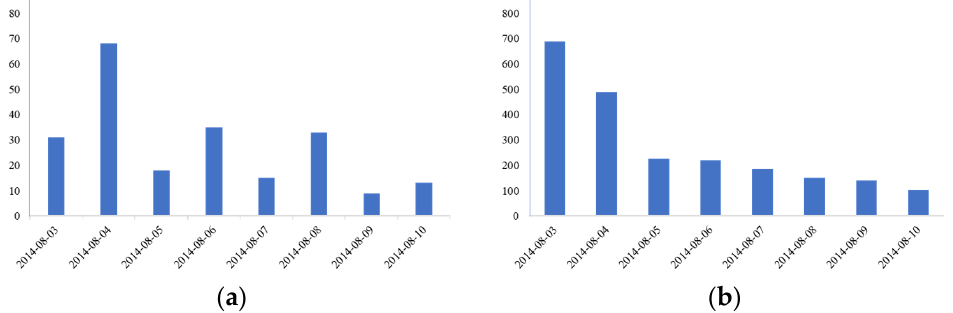
Figure 4. Daily amount of microblog messages; ( a ) used method a , ( b ) used method b .